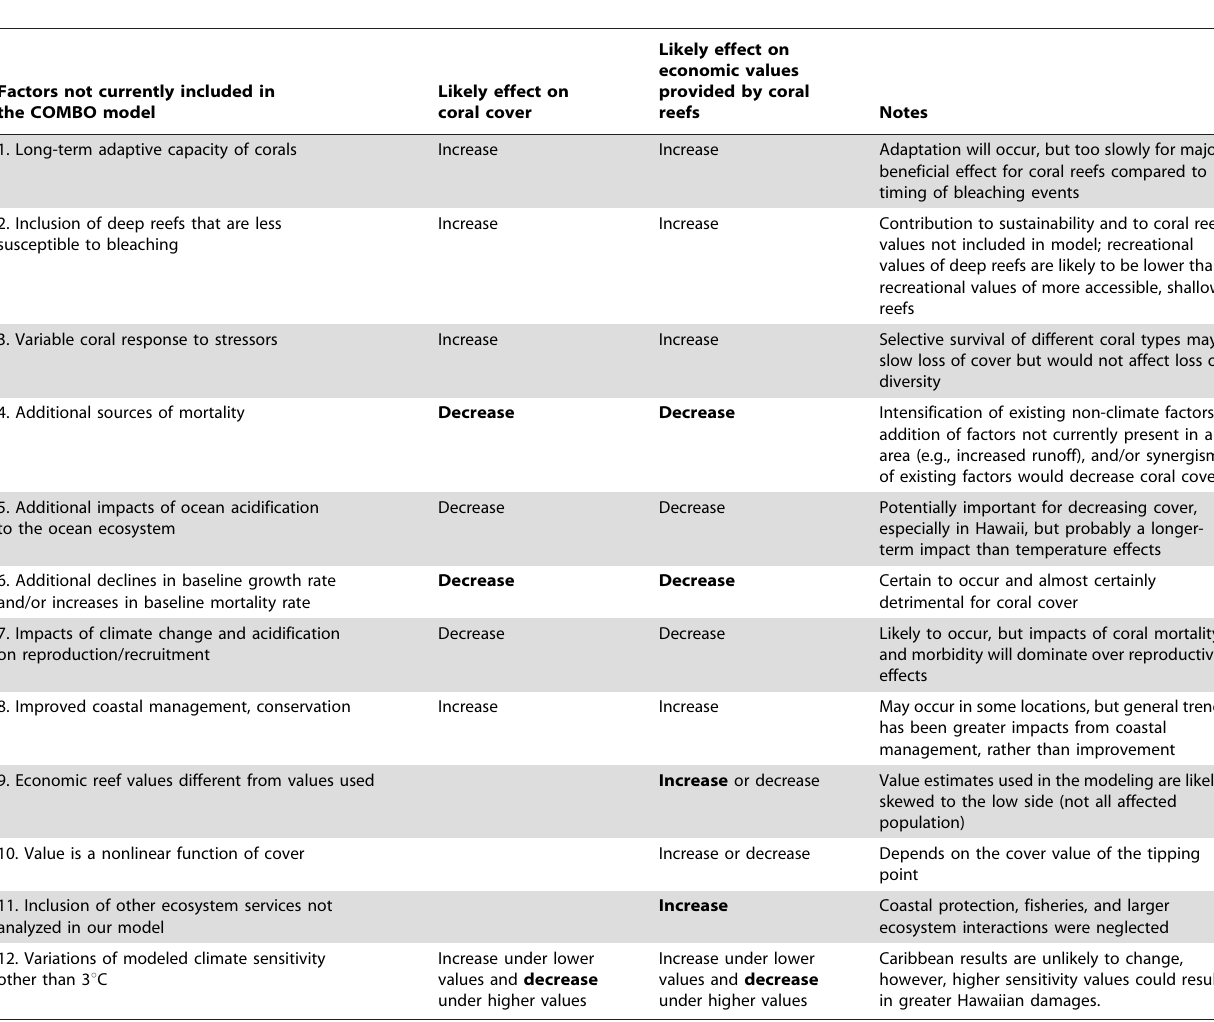
Table 6. Likely effects of uncertainty factors on ecological and economic values of coral reefs, compared to model projections for BAU and policy scenarios a